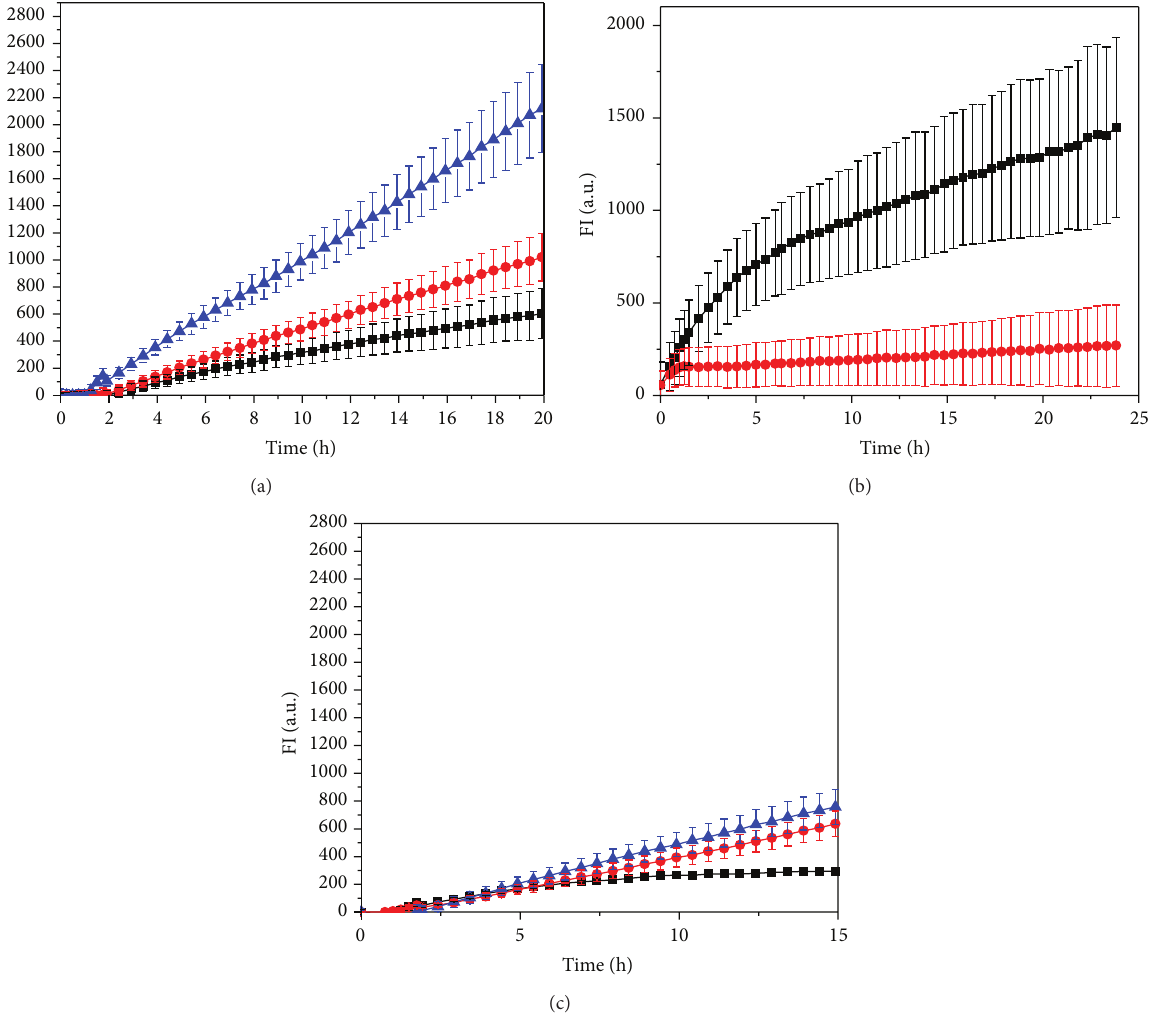
Figure 4: (a) Time courses for the increase in resorufin fluorescence FI a.u. (fluorescence intensity, arbitrary units) due to C. pneumoniae is measured by the Amplex Red assay. The reactions were started by the addition of 0.5 × 10 7 ( ◼ ), 1 × 10 7 ( e ), and 3 × 10 7 ( 󳵳 ) inclusion forming units (IFUs) of bacteria in SPG and in a total volume of 200 𝜇 L at 37 ∘ C. (b) SMase activity of C. pneumoniae measured by the Amplex Red assay. The reactions were started by the addition of 3 × 10 7 IFUs (in 30 𝜇 L of SPG buffer) in the presence of either 9mM CaCl 2 ( ◼ ) or 9mM CaCl 2 and 35 mM EDTA ( e ) and in a total volume of 200 𝜇 L. Temperature was 37 ∘ C. (c) SMase activity of C. pneumoniae in SPG buffer ( 󳵳 ) and with either 2mM MgCl 2 ( ◼ ) or 2 mM MgCl 2 and 4mM EDTA ( e ). The Amplex Red assays for SMase were started by the addition of 1.5 × 10 7 IFUs of bacteria, incubated in a total volume of 200 𝜇 L at 37 ∘ C.